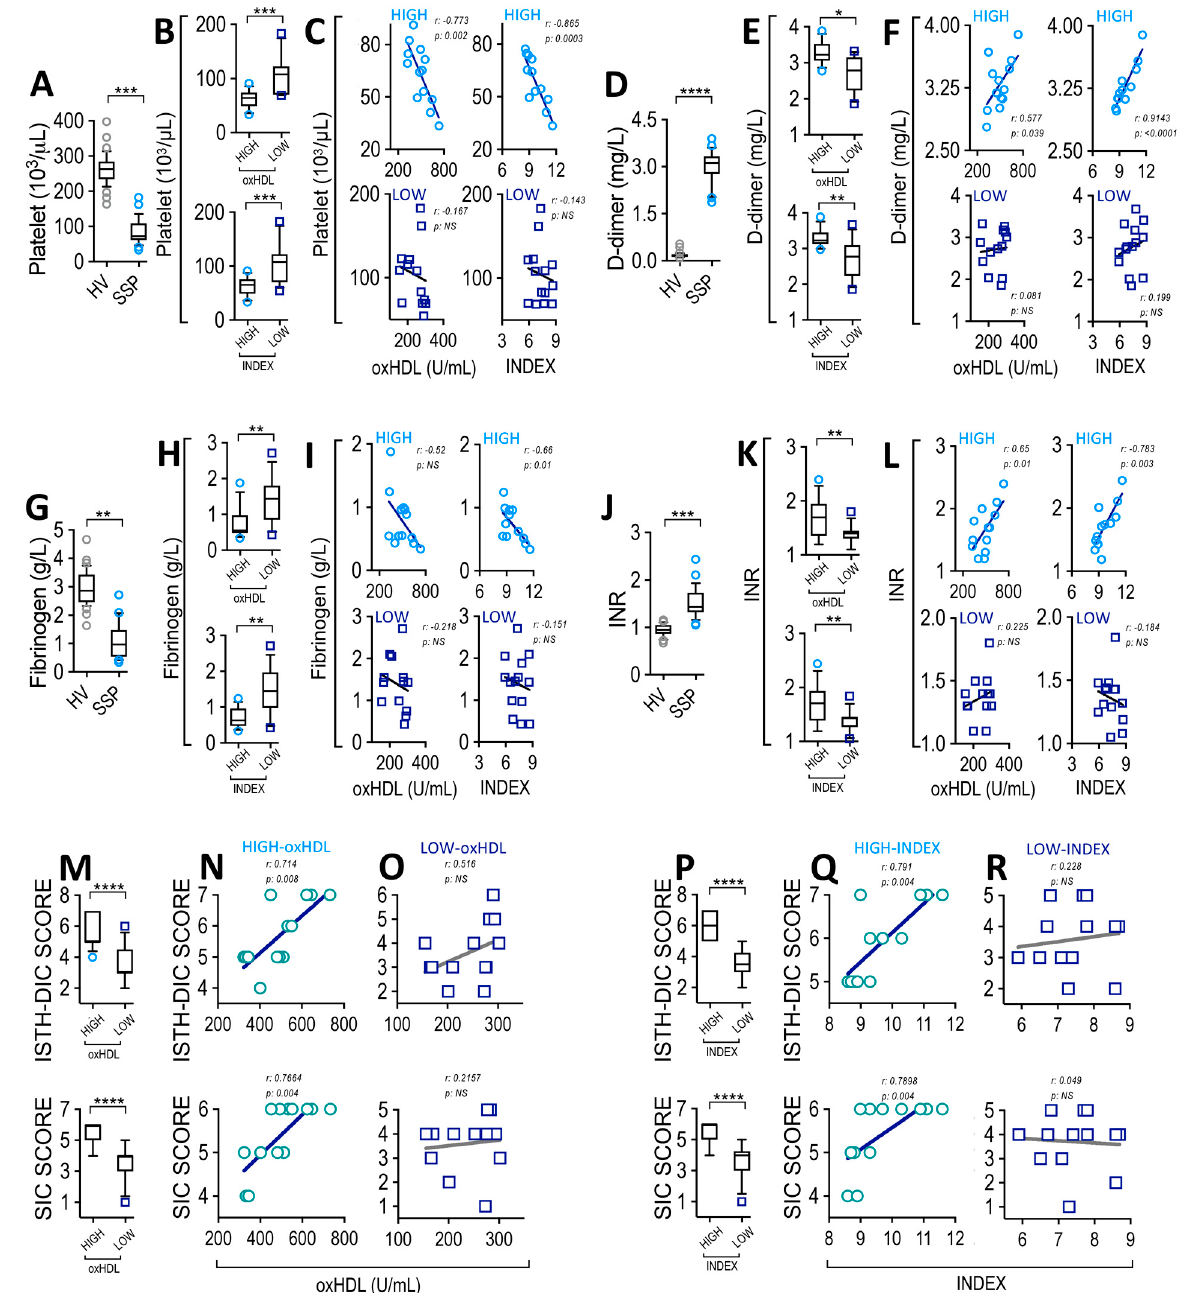
Figure 3. Plasma level of ISTH-DIC and SIC parameters correlates with oxHDL and INDEX in SSP. Plasma level of platelet count ( A ), D-dimer ( D ), fibrinogen ( G ), and INR ( J ) in HV and SSP. Plasma level of platelet count ( B ), D-dimer ( E ), fibrinogen ( H ), and INR ( K ) in high- and low-oxHDL and high- and low-INDEX groups from SSP. Statistical differences were assessed with student’s t-test (Mann– Whitney). * p < 0.05, ** p < 0.01, *** p < 0.001, **** p < 0.0001. Correlation analyses between: platelet count with high-oxHDL (( C ), upper-left panel, r = − 0.773; p = 0.002), low-oxHDL (( C ), lower-left panel, r = − 0.167; p = NS), high-INDEX (( C ), upper-right panel, r = − 0.865; p = 0.0003) and low- INDEX (( C ), lower-right panel, r = − 0.1430; p = NS), D-dimer with high-oxHDL (( F ), upper-left panel, r = 0.577; p = 0.039), low-oxHDL (( F ), lower-left panel, r = 0.081; p = NS), high-INDEX (( F ), upper-right panel, r = 0.9143; p < 0.0001) and low-INDEX (( F ), lower-right panel, r = 0.1998; p = NS), fibrinogen with high-oxHDL (( I ), upper-left panel, r = − 0.52; p = NS), low-oxHDL (( I ), lower-left panel, r = −